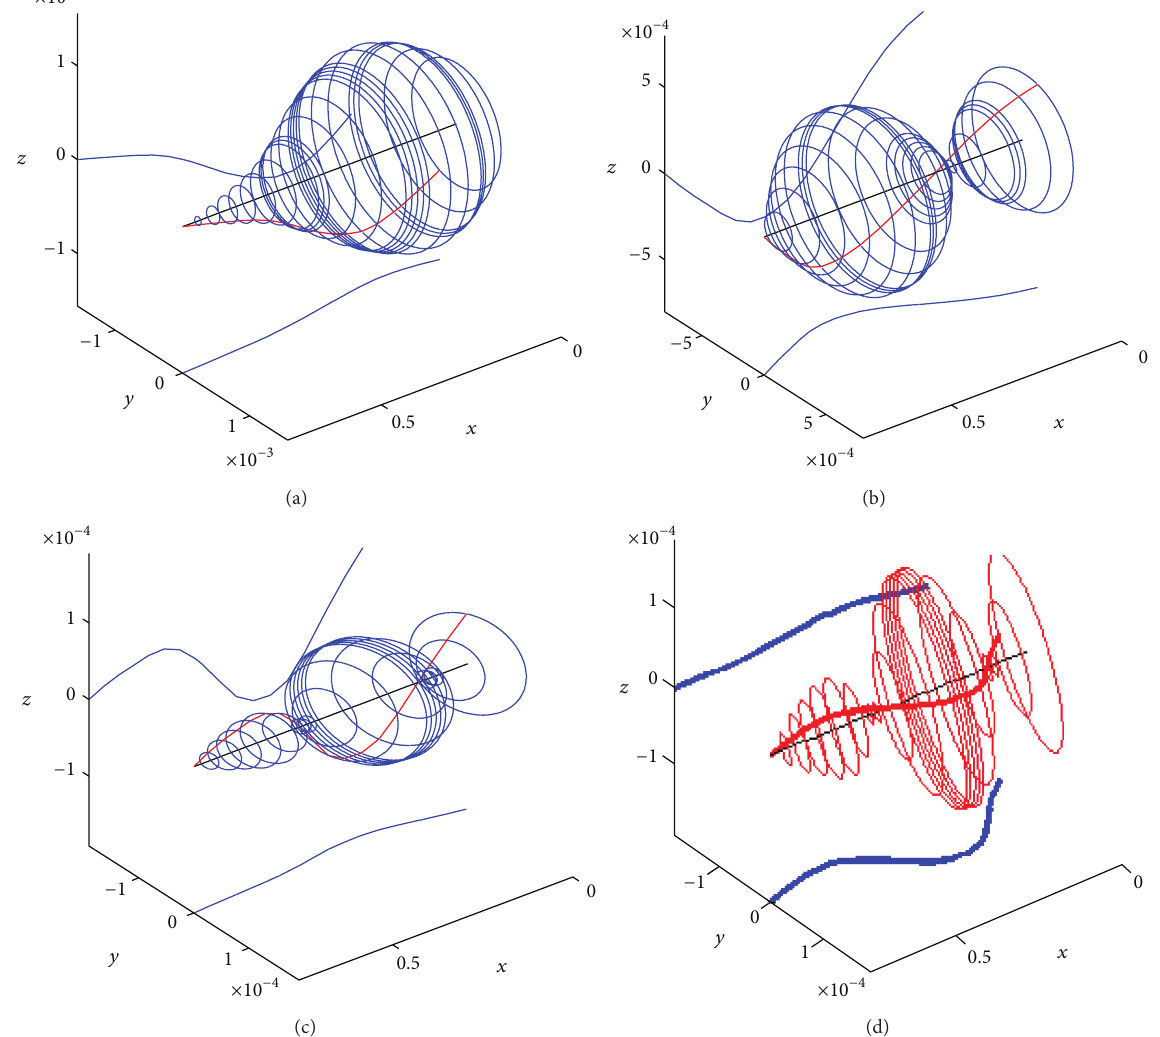
Figure 8: Natural modes of configuration B for a rotational speed of 40 Hz: (a) bearing 2 fluid frequency at 20.94 Hz; (b) bearing 1 fluid frequency at 21.85 Hz; (c) first forward flexural natural frequency at 74.89 Hz; (d) first backward flexural natural frequency at 74.882 Hz.